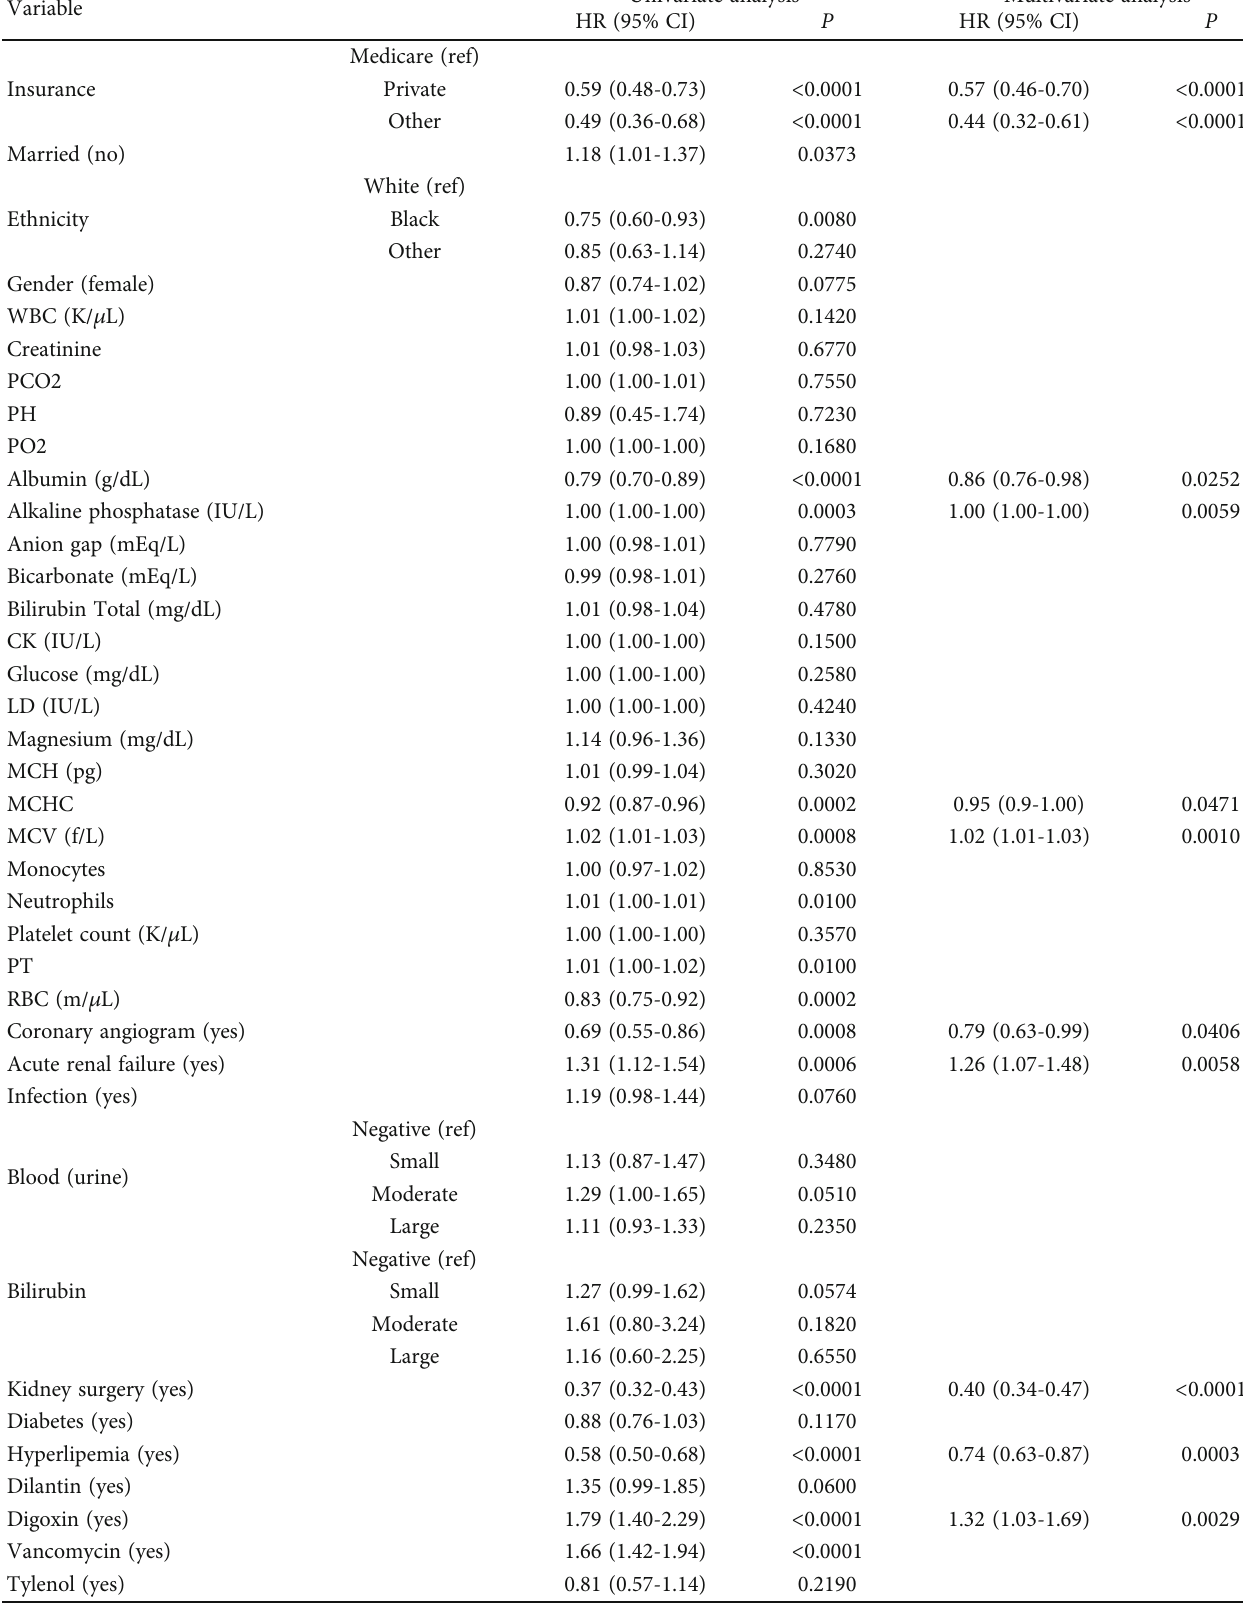
Table 2: Features selection (univariate and multivariate